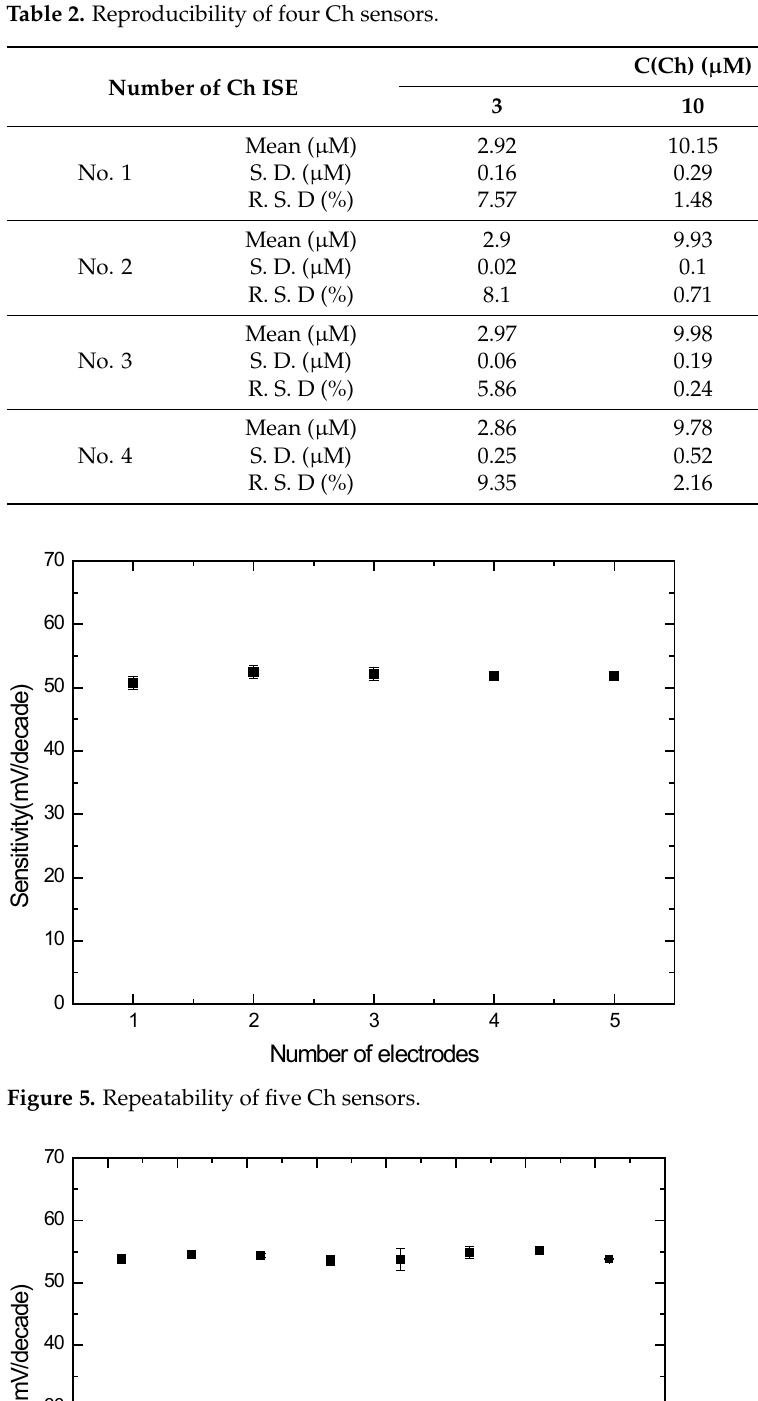
Table 2. Reproducibility of four Ch sensors.